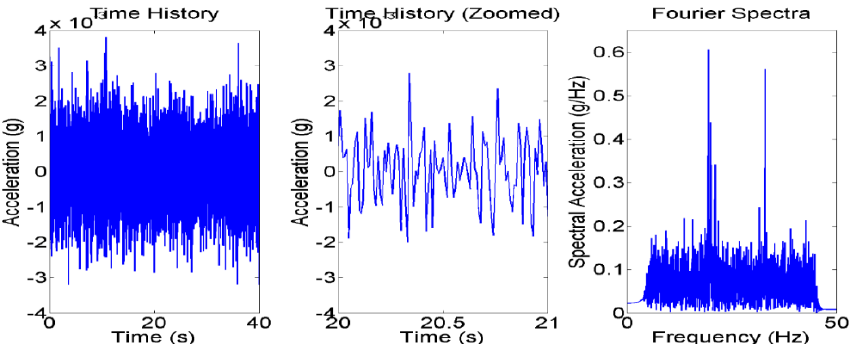
Figure 4. Exemplary crowdsourced submission time histories and Fourier spectra.